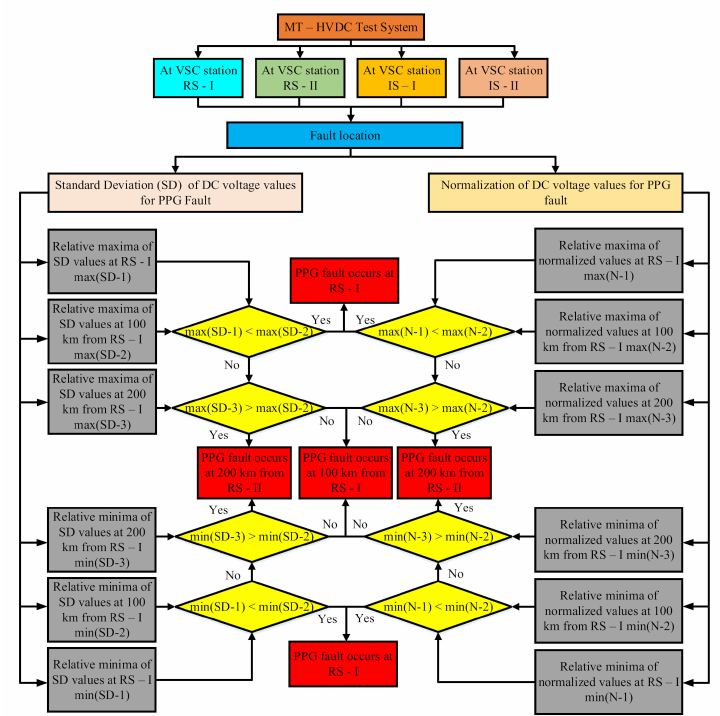
Figure 4. An algorithm for positive pole to ground (PPG) fault location finding based on SVM, using supported features of standard deviation and normalization of DC voltage.